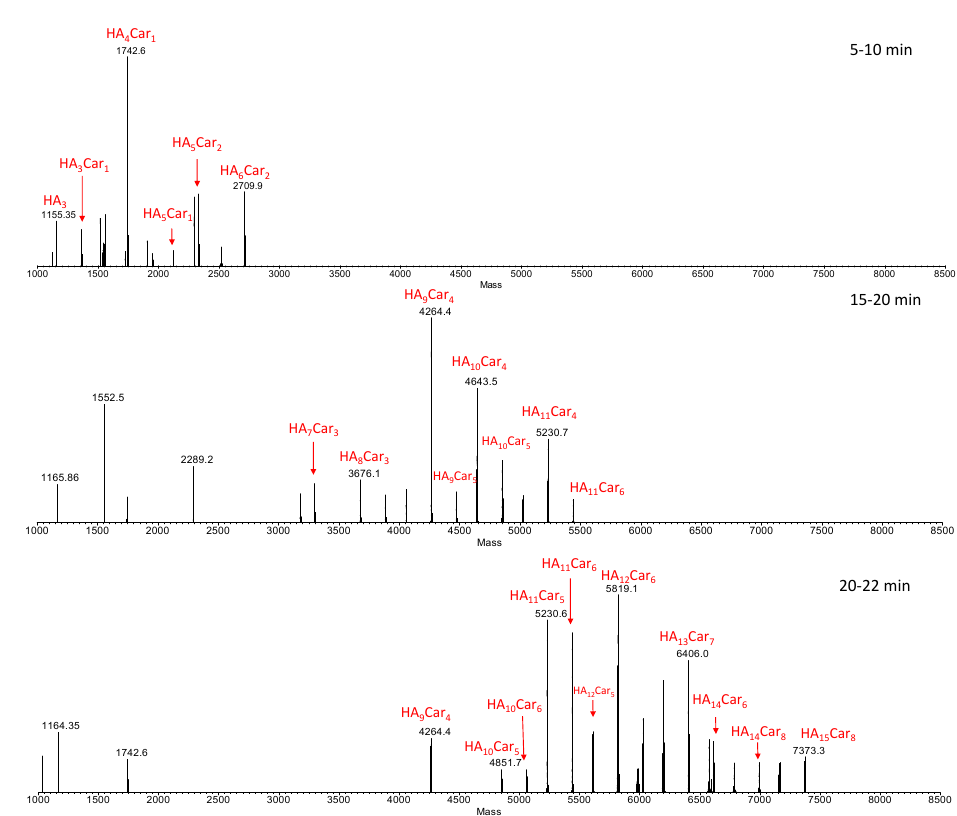
Figure 3. Deconvoluted spectra obtained from the average MS spectra acquired during the LC-MS analysis within specific RT ranges (5–10, 15–20 and 20–22 min). The species show the number of repetitive units (HA) and that of carnosine (Car). The sample was obtained by the hydrolysis of HyCar20 catalyzed by HyAse (500 U/mL).